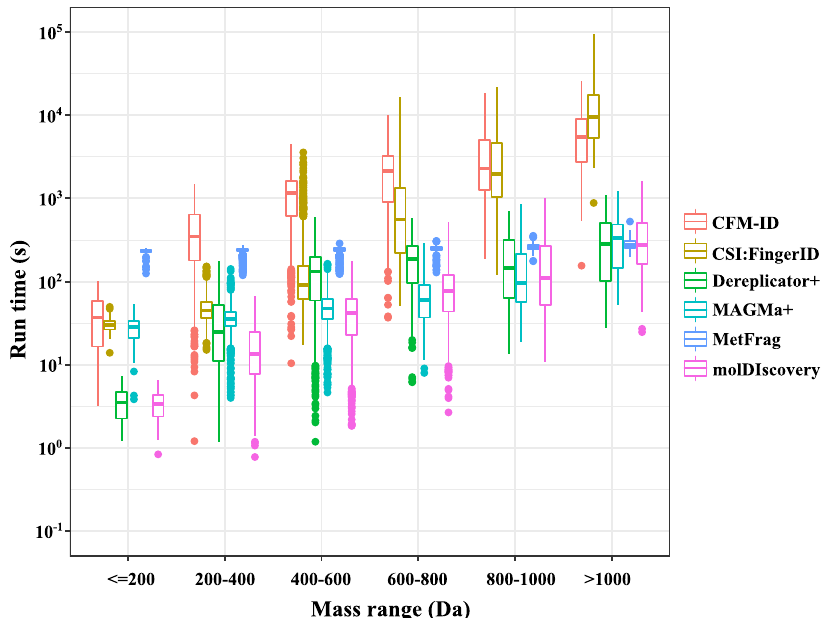
Fig. 4 Running time comparison of different methods for compounds in the GNPS subset within different mass ranges. Inputs that caused any method to crash or exceed 20 GB of memory usage were excluded from this analysis. All reported running times and memory usages are without preprocessing (molDiscovery, Dereplicator + and CFM-ID could be run with or without preprocessing). In the boxplot, center lines are medians. Box limits are upper and lower quartiles. Whiskers are 1.5× interquartile range. Points are